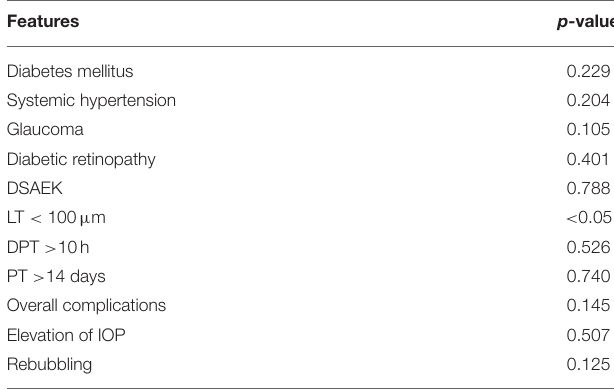
TABLE 5 | Analysis of both recipient- and donor-related factors on BCVA improvement by regression models corrected for n